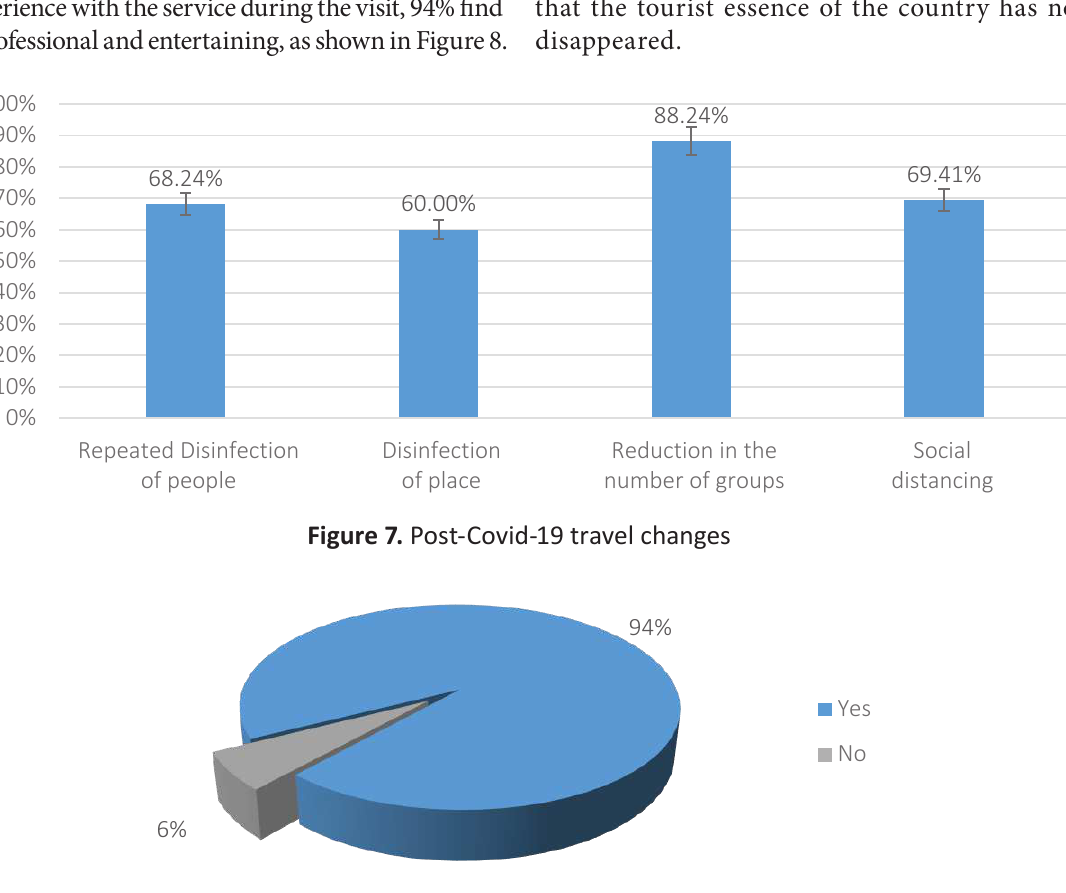
Figure 8. Do you find the service during the visit professional and